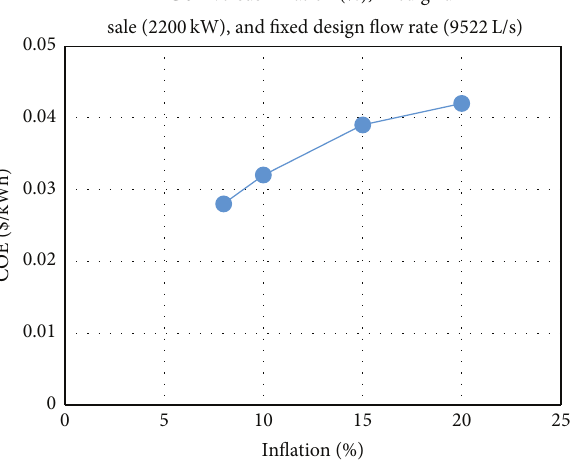
Figure 12: Relation between costs of energy versus